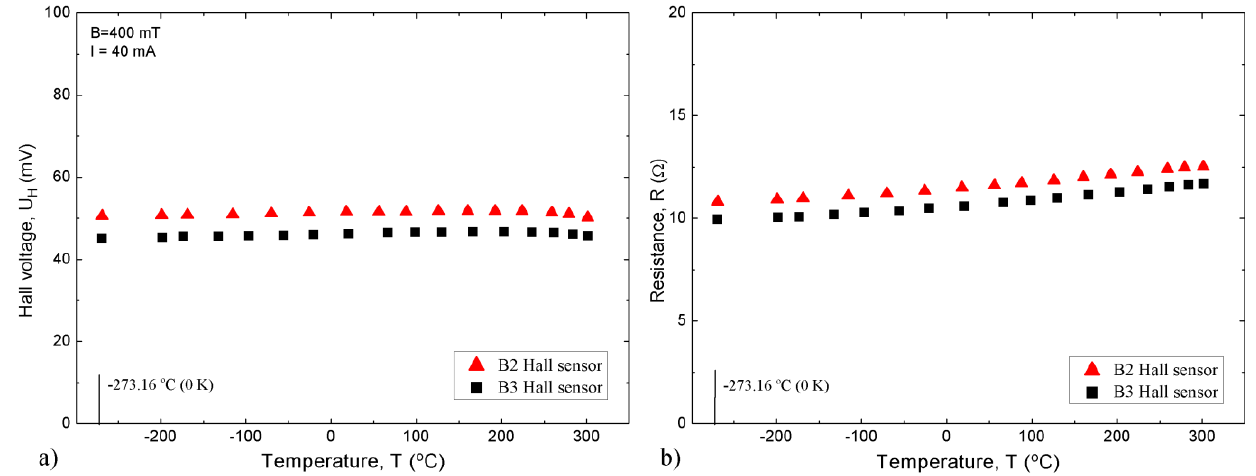
Figure 3. Temperature dependence of (a) Hall voltage U and